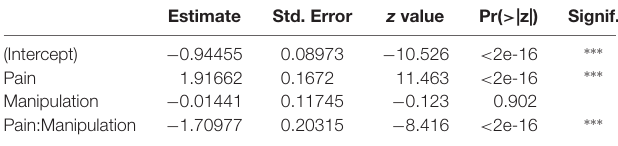
TABLE 2 | Parameter estimates, their standard errors, z test statistic values and associated p -values for the location parameter in the beta generalized linear model (GLM) model for the time fraction place escape avoidance paradigm (PEAP) data.